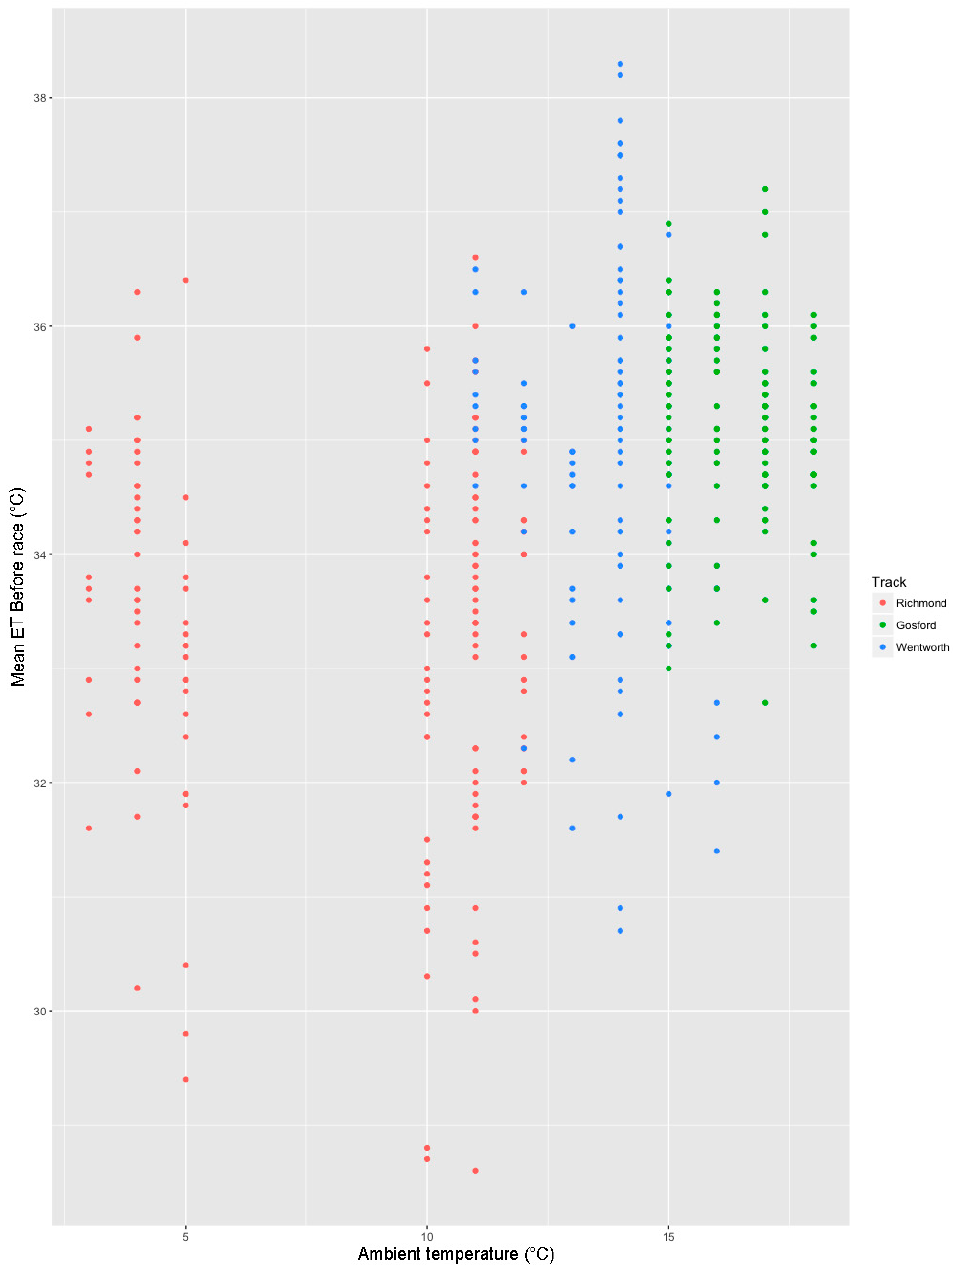
Figure 6. Scatter plot showing the relationship between Eye Temp Before the race and ambient temperature for each track. Ambient temperature was not included in the model to predict Eye Temp Before because its addition to the model worsened the fit of the model according to the Akaike Information Criterion